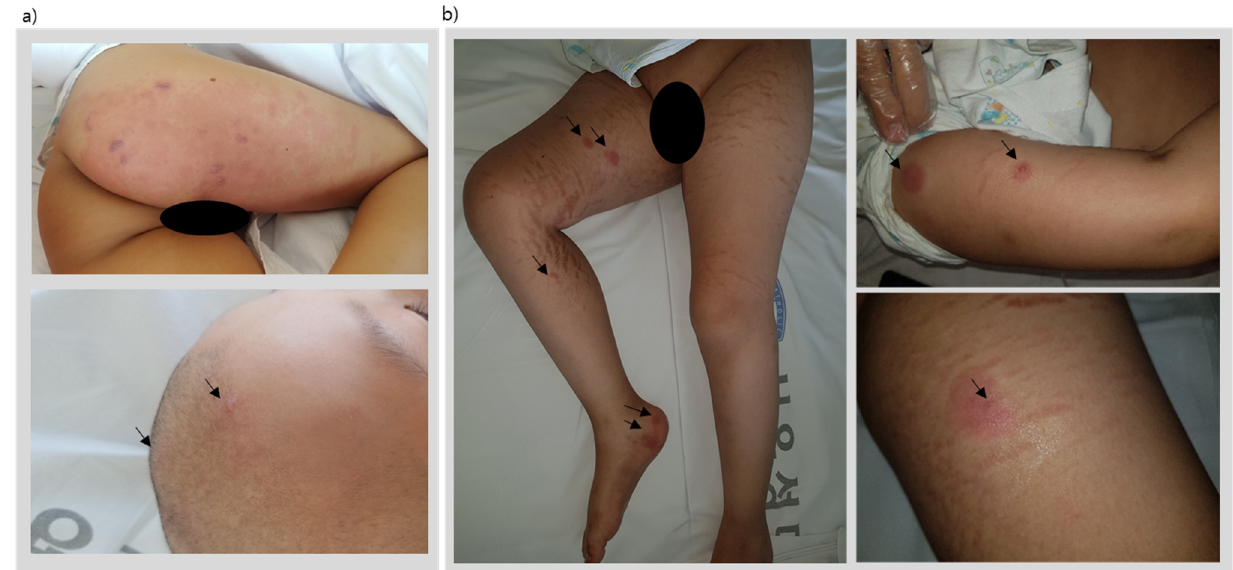
Figure 1. Disseminated herpes zoster lesions, ( a ) showing painful multiple erythematous vesicles on the skin involving the right L2-5 dermatome and trigeminal V1 dermatome evolving to form pustules and crusts within a course of two weeks, and ( b ) vesicles appearing only on skin areas with lymphoma cutis involvement.